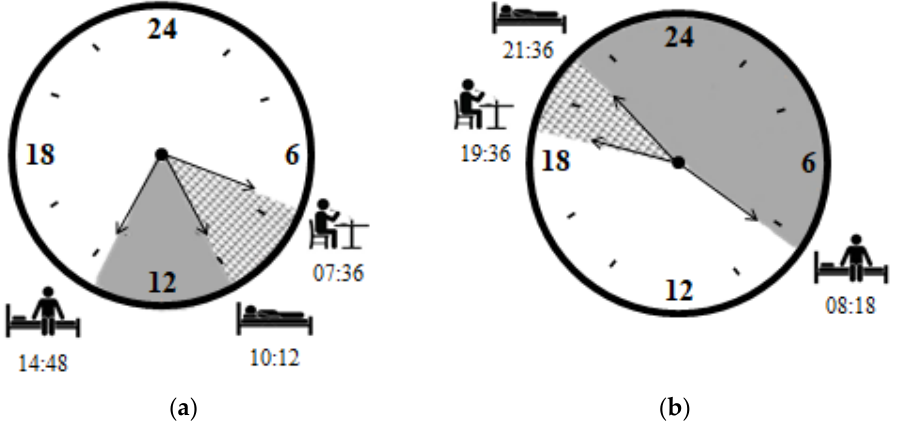
Figure 2. Mean times (clock time) of last meal before bedtime, of sleep onset and of getting up after: ( a ) night shift ( n = 22); and ( b ) day-off ( n = 22). Results for mean daily intake of macronutrients on workdays and days-off reveal that both were in line with nutritional recommendations: workdays (fat: 31.1%, SE 1.3%; carbohydrate: 49.8%, SE 1.7%; protein: 18.3%, SE 1%); days-off (fat: 29.4%, SE 1.3%; carbohydrate: 51.5%, SE 1.8%, protein: 18%, SE 1.1%). Analysis of the composition of last meal before bedtime showed that mean percentages of macronutrients were adequate: workdays (fat: 26.4%, SE 2.5%; carbohydrate: 60.5%, SE 3.2%; protein: 14.9%, SE 1.8%); days-off (fat: 28.5%, SE 2.7%; carbohydrate: 58.5%, SE 3.7%; protein: 14.7%, SE 2.1%). There was no statistically significant difference between workday and the day-off for the 24-h period and last meal before bedtime. Although these results suggest macronutrient intake of participants was adequate, most participants had inadequate fat and carbohydrate consumption, both for the 24 h recording period, and last meal before bedtime after the night shift and on the day-off (Figure 3).